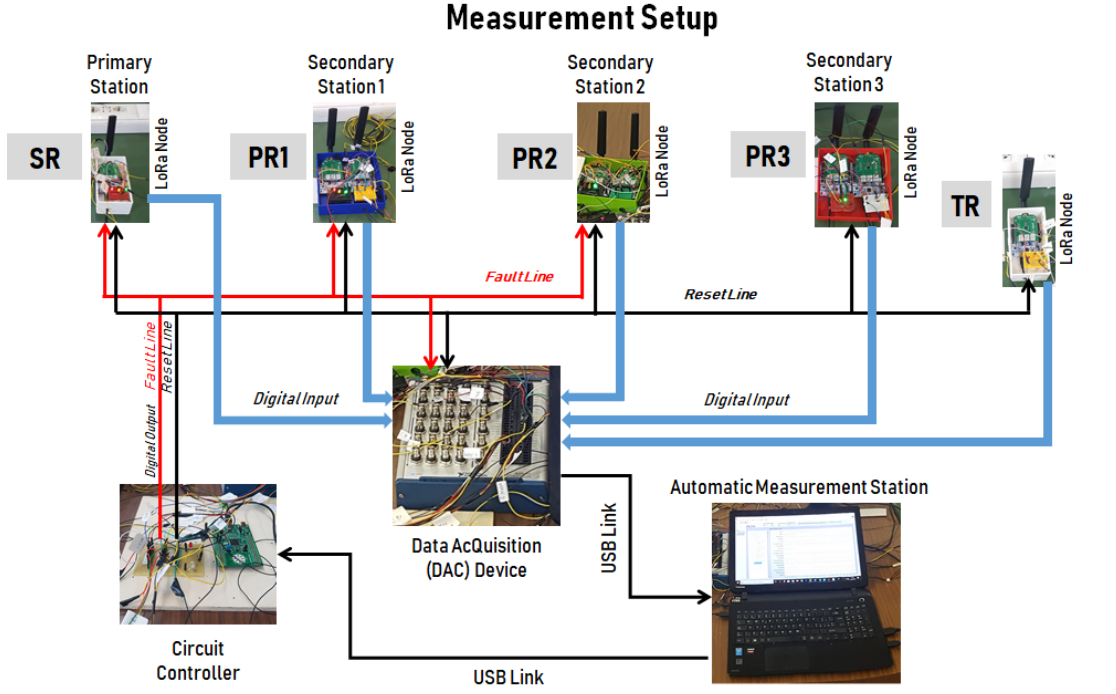
Figure 3. Realized demonstrator for the experimental assessment of the